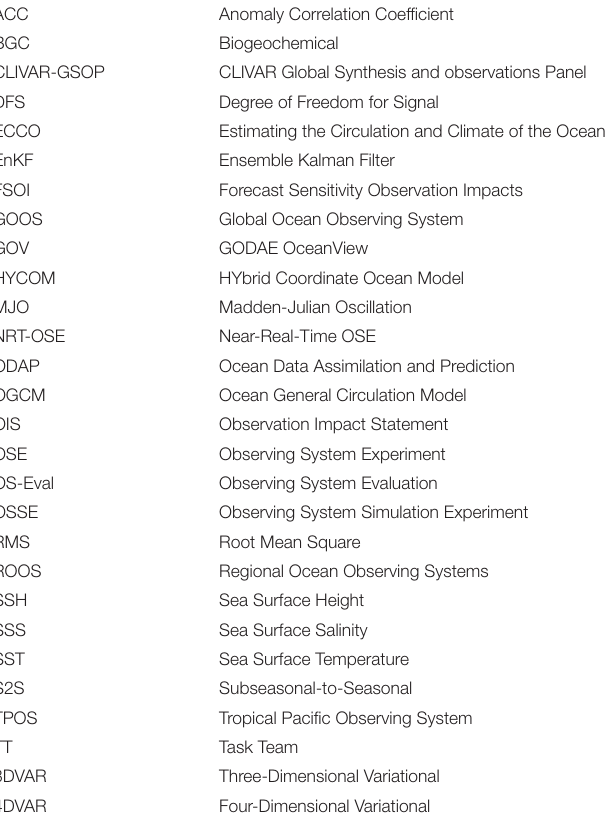
TABLE 1 | Essential acronyms used in this